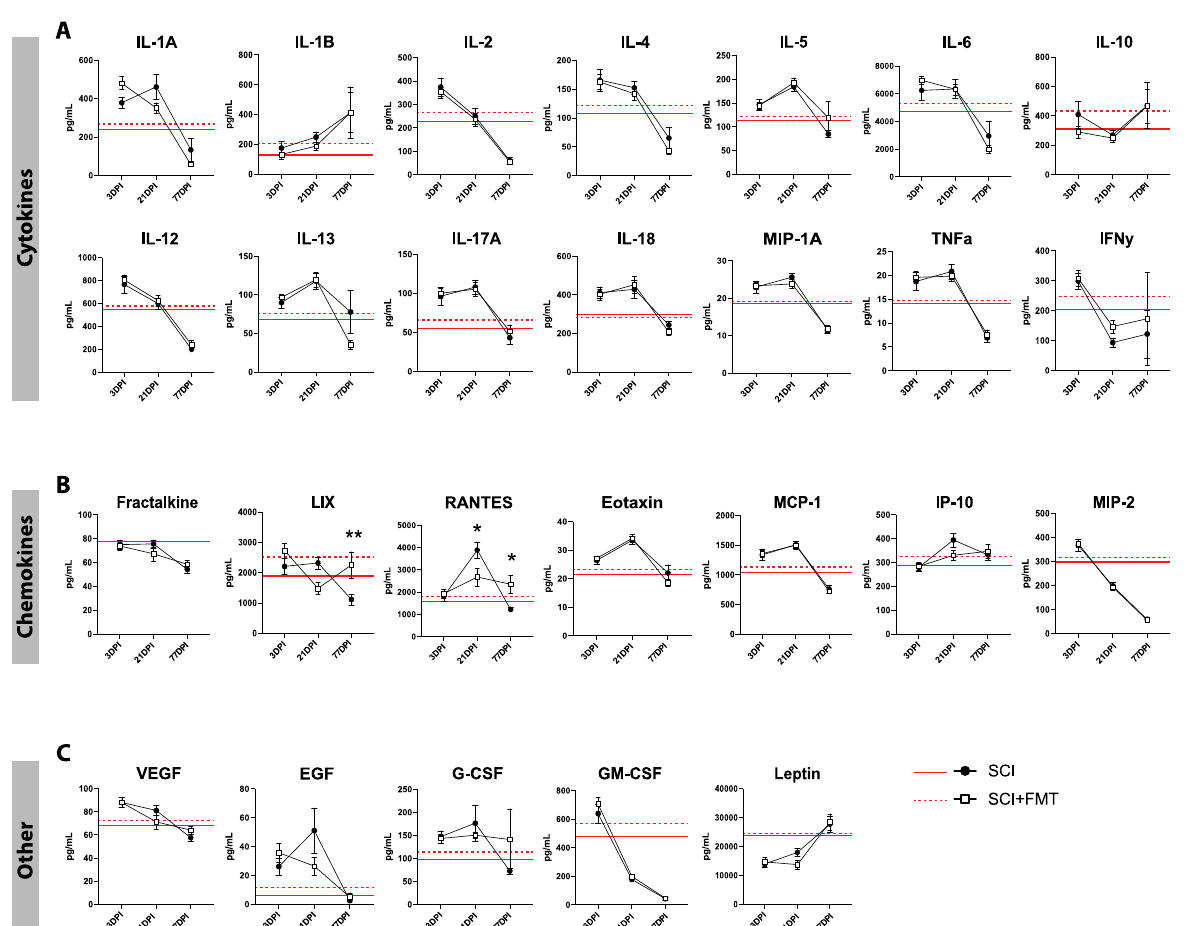
Figure 8. SCI induced time-dependent changes in plasma cytokines and chemokines. ( A ) Temporal profile of plasma cytokines 3 days post injury (3DPI), 21 days post injury (21DPI) and days post injury (77DPI) for SCI + Vehicle and SCI + FMT groups. ( B ) Temporal profile of plasma chemokines show that SCI + FMT rats have significantly increased levels of LIX and RANTES at 77 days compared to vehicle controls. ( C ) Profile of other plasma markers (growth factors, glycoproteins and hormones) over time after injury. Red lines represent baseline values. * p < 0.05. ** p < 0.01. Error bars represent standard error mean.